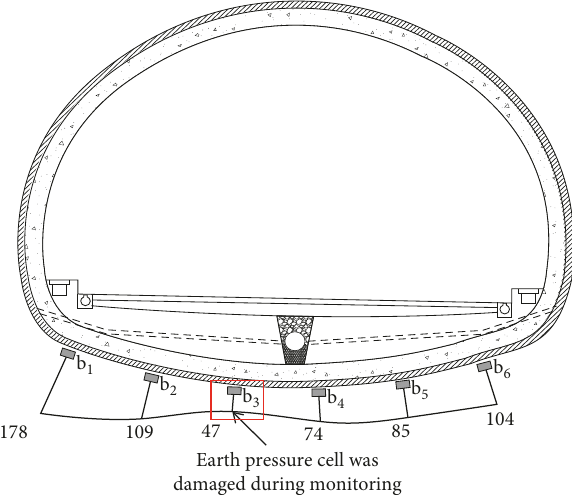
Figure 11: Distribution of the earth pressure